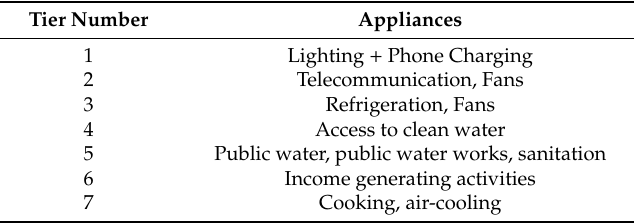
Table 1. Multi-tier Framework for Energy Access.